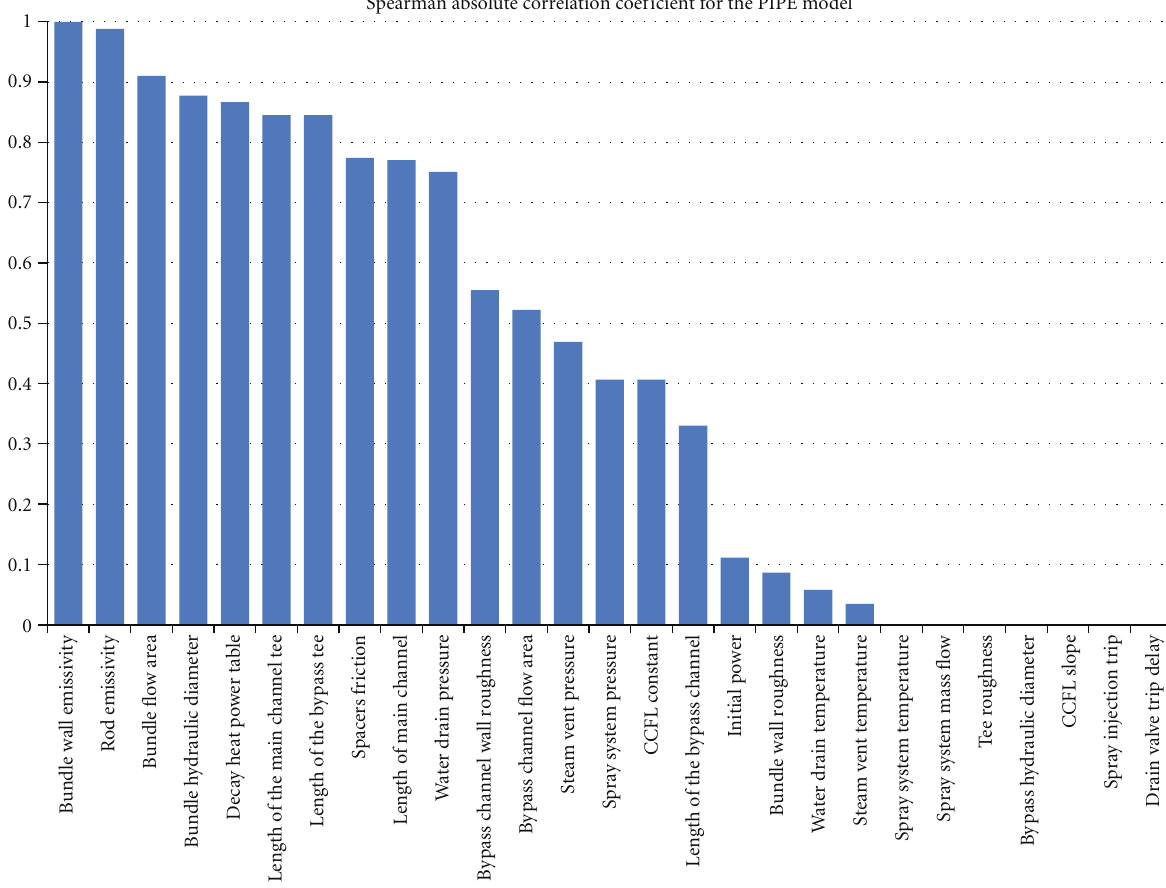
Figure 11: Absolute Spearman correlation coe ffi cient for the PCT for the PIPE